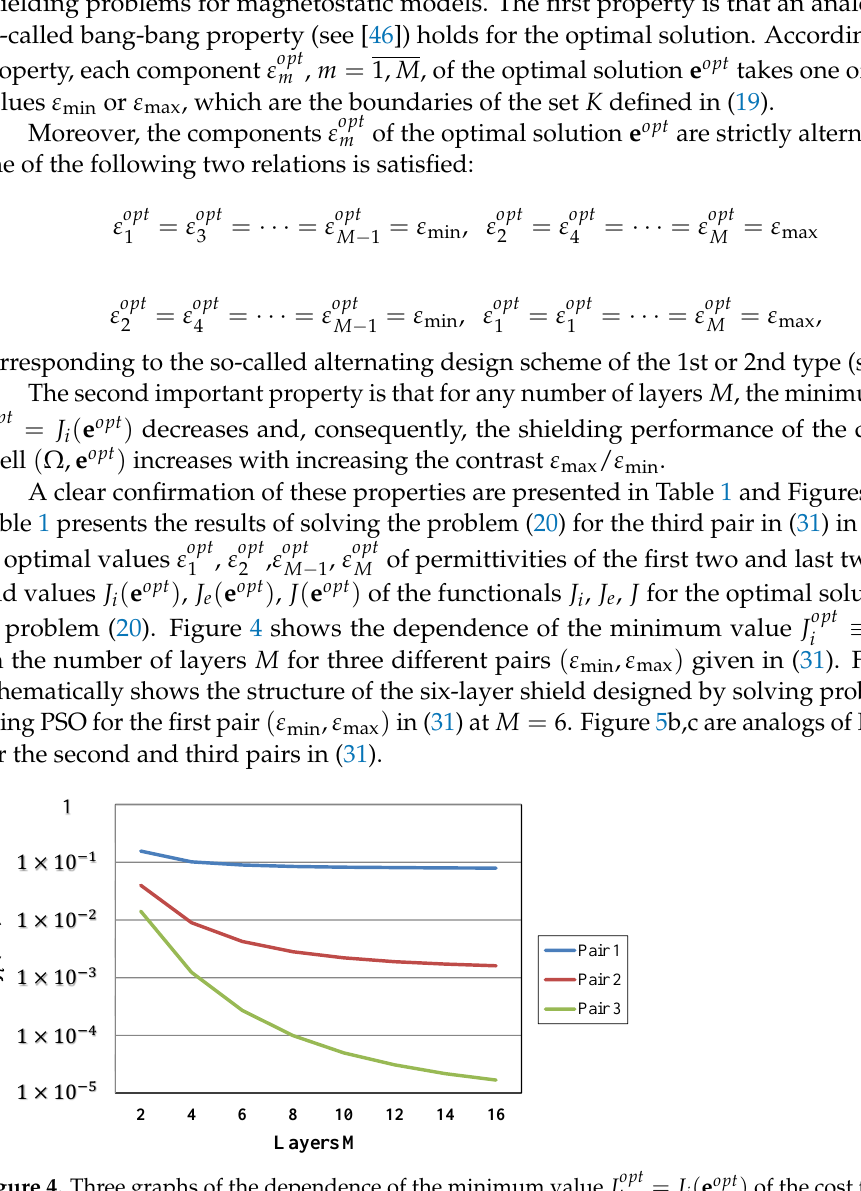
Figure 4. Three graphs of the dependence of the minimum value J opt J i corresponding to the shielding problem on the number of isotropic layers M for three different pairs ( ε min , ε max ) given in